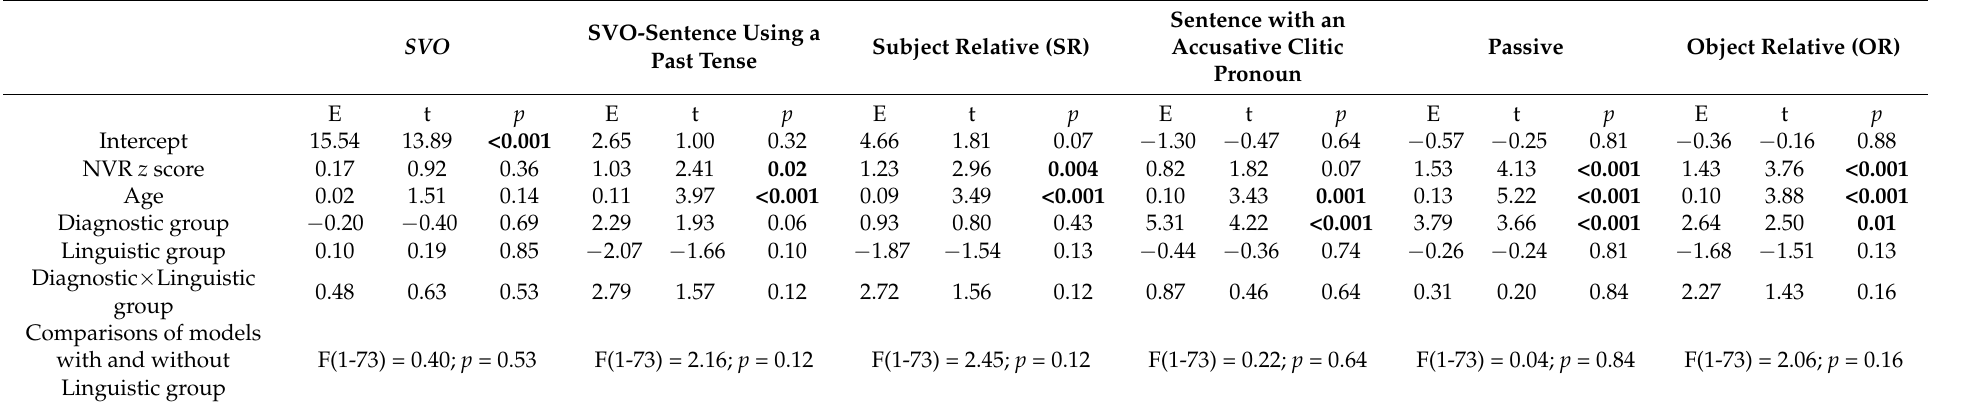
Table A3. Linear regression of each structure score using age, nonverbal reasoning z score, and diagnostic and linguistic groups and the interaction of these two as independent variables. SVO-Sentence Using SVO